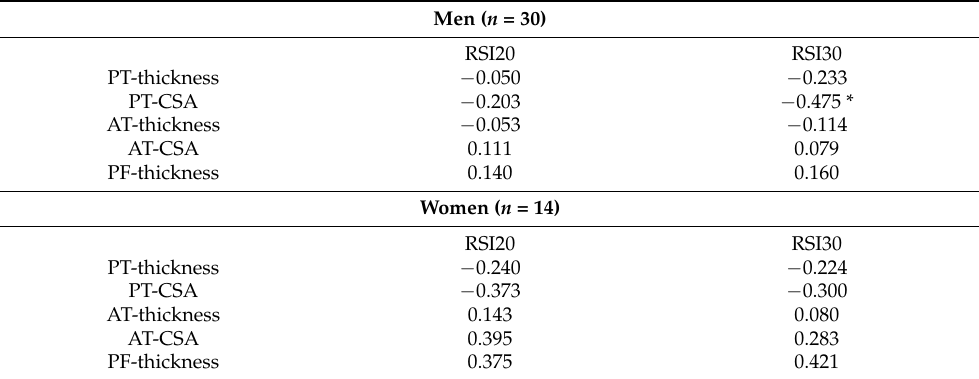
Table 1. Relationship (coefficient r) between normalized to body mass connective tissue morphology and jumping performance parameters.